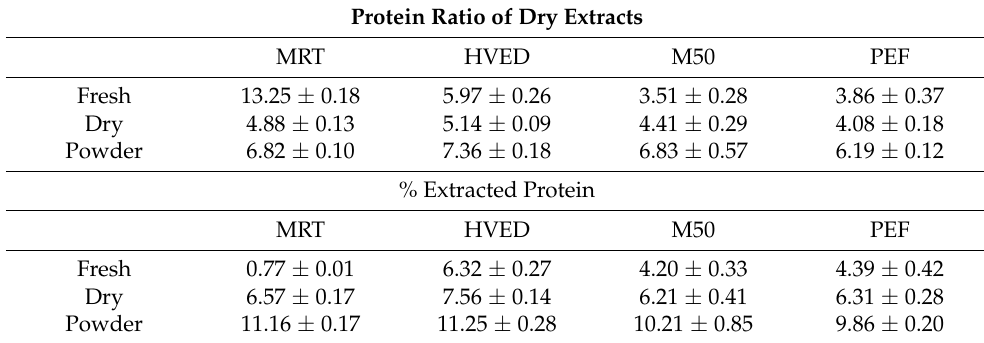
Figure 4. Final extracted protein yields in different treatments. Ratio dry algae/solvent of 1:20 ( w / v ). Solid fill: fresh GC; dashed fill: dry GC; dotted fill: powdered GC. Data are shown as mean ± SD (n = 4). Upper case letters signify differences between treatments (values averaged across state). Lower case letters denote significant differences between treatments by state. Type III ANOVA with Tukey post-hoc test. Table 4. Protein ratio of dry extracts and percentage of extracted protein over total algal protein n =